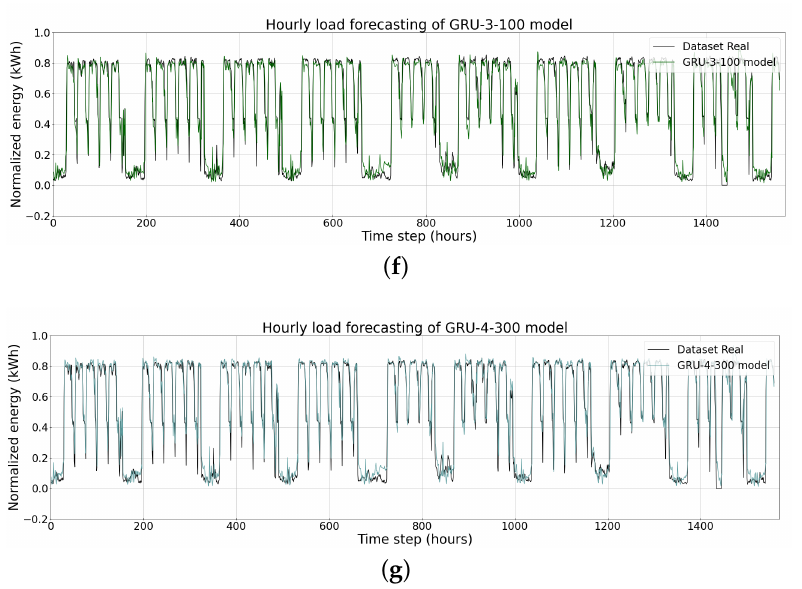
Figure 14. Hourly load forecasting using ( a ) the RNN-3-400 model; ( b ) the RNN-4-200 model; ( c ) the LSTM-3-200 model; ( d ) the LSTM-3-300 model; ( e ) the LSTM-4-400 model; ( f ) the GRU-3-100 model; and ( g ) the GRU-4-300 model.